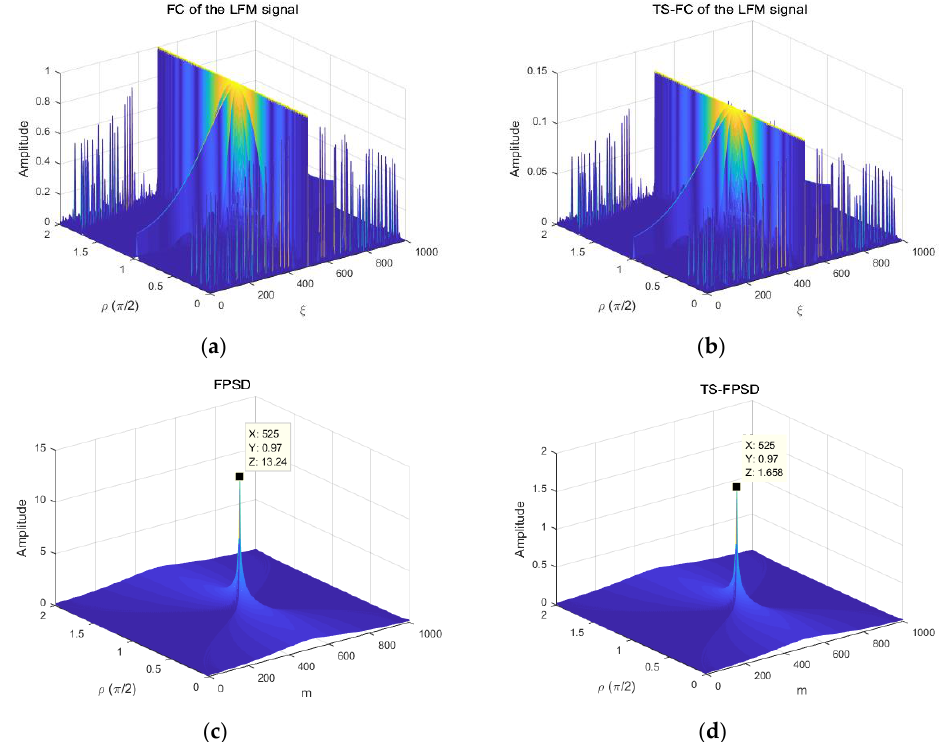
Figure 6. The LFM signal in the FRFT domain. ( a ) the FC of the LFM signal; ( b ) the TS-FC of the LFM signal; ( c ) the FPSD of the LFM signal; ( d ) the TS-FPSD of the LFM signal.